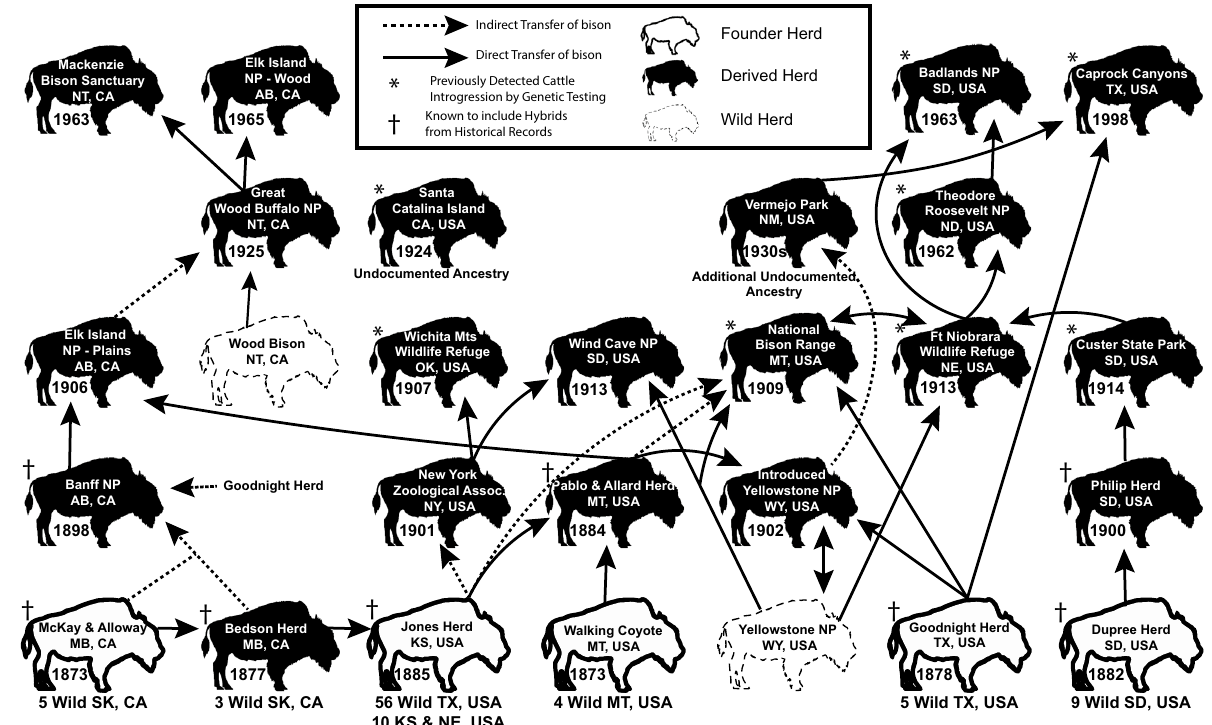
Figure 1. This graph represents the survival and repopulation of bison by tracking the major founding lineages from wild captured bison to modern populations.The wild herds depicted represent the only populations of bison that survived the population bottleneck in the wild. The founder herds were privately owned bison that were established with bison captured from the wild. The wild and founder herds, seven in total, are the only herds that were in existence during the nadir of the population crash and represent the seven lineages of bison. The derived herds are those that were established with bison from one or more of the seven lineages. The solid arrow (direct transfer) represents direct movement of bison from one population to another, while the dashed line (indirect transfer) represents movement of bison with one or more intermediate populations between the populations depicted. This graph does not include all bison movement but is instead meant to show the contribution and influence that the founding herds have on modern populations based on documented evidence of transferring bison. This figure also identifies populations that are known to have domestic cattle introgression whether through historical documentation or modern genetic testing and the years when each population was established. The Banff National Park population is not the same as the reintroduced animals that currently reside in the park 16,17–19